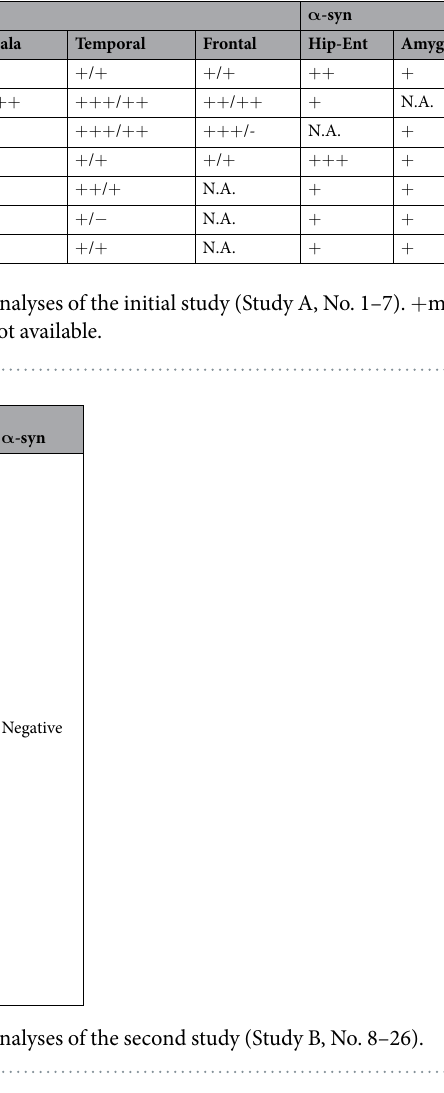
granules appeared smaller than the tau-positive grains observed in argyrophilic grain disease (AGD) brains, and they were negative for Gallyas-silver staining (data not shown). Furthermore, tau-positive astrocytic structures, resembling “bush-like” astrocytes previously reported in AGD 33 , were found in the cortex in all cases in Study A. Their morphology was significantly different from the tufted-astrocytes in progressive non-fluent aphasia (PSP) patients, the astrocytic plaques in corticobasal degener- ation (CBD) or the ramified astrocytes in Pick’s disease (Fig. 2D). In the white matter, tau-positive oligodendro- glial coiled bodies were observed (Fig. 2E). Gallyas silver staining also revealed structures similar to those stained with AT8, including neurofibrillary tangles (NFTs), threads, and astrocytic and oligodendrocytic structures (data not shown). In the hippocampal region, many NFTs were found in cases 2 and 4 by both AT8 immunostaining and Gallyas silver staining (data not shown). The control cases of Study A showed mild to moderate AT8-positive structures and less glial tau deposi- tion compared to GRN mutation cases (Table 2). Case 1, 2, 4 and 5 exhibited tau deposition that corresponded to Braak stage IV, Case 3 corresponded to Braak stage V and Case 6 and 7 corresponded to Braak stage I, respectively (Table 2). The degree of accumulation of tau was evaluated qualitatively and a score ranging from – (negative) to +++ (severe) was assigned (Supplementary Figure 1 and Table 2). In Study B, eight of nine GRN mutation cases exhibited some AT8 immunoreactivity (Supplementary Figure 2 and Table 3), but the levels of phosphorylated tau deposition were up to Braak stage II except for Case 9 (Table 3), dissimilar to that seen in GRN mutation cases of Study A. No tau deposition or only Braak stage I-II were observed in the control cases of study B (Table 3). The tau pathology in the GRN mutation cases (Study A) was also detected by 3-repeat (3R)-tau (RD3) and 4-repeat (4R)-tau (anti-4R) specific antibodies indicating that both 3R and 4R tau accumulation was present (Data not shown). α -synuclein accumulation in GRN mutation cases.